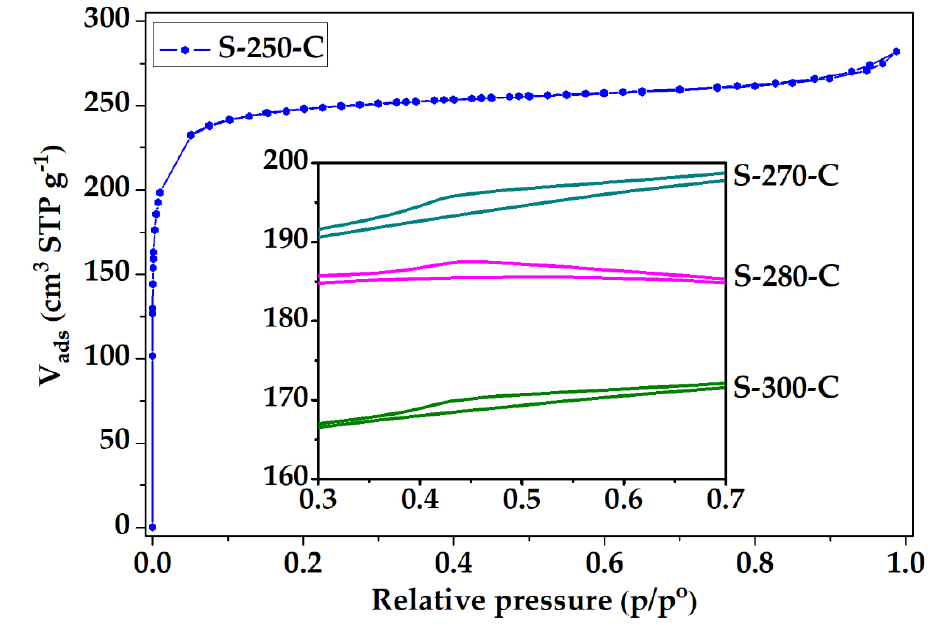
Figure 3. Nitrogen physisorption isotherms of CMF.